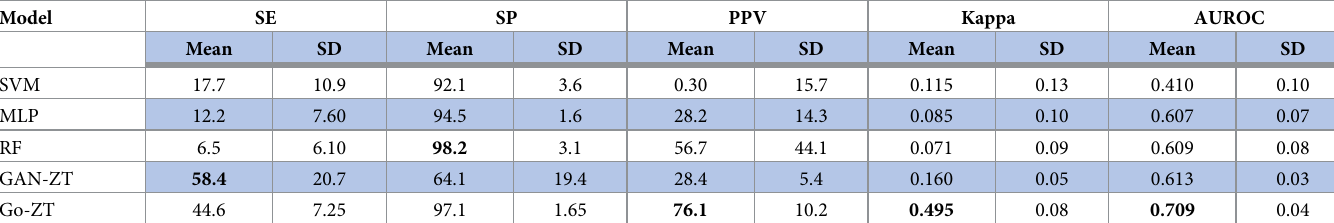
Table 2. Performance of different methods in activity classification with 10-fold cross-validation.